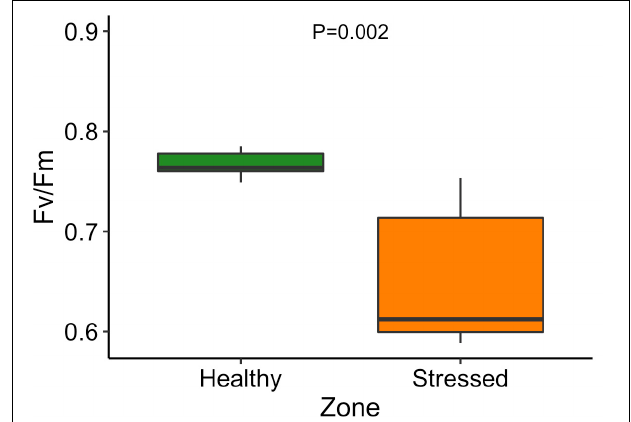
FIGURE 9 | Maximal chlorophyll fluorescence (Fv/Fm) of “stressed” and “healthy” Avicennia marina at the St Kilda mangrove forest, South Australia. The measurements were taken on the second youngest leaves. Four leaves were measured from each of seven plants per